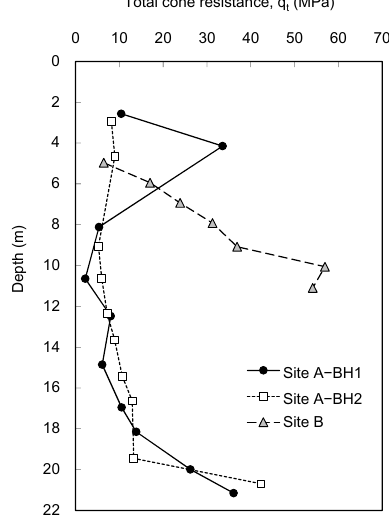
Figure 15. Profiles of the average total cone resistance.